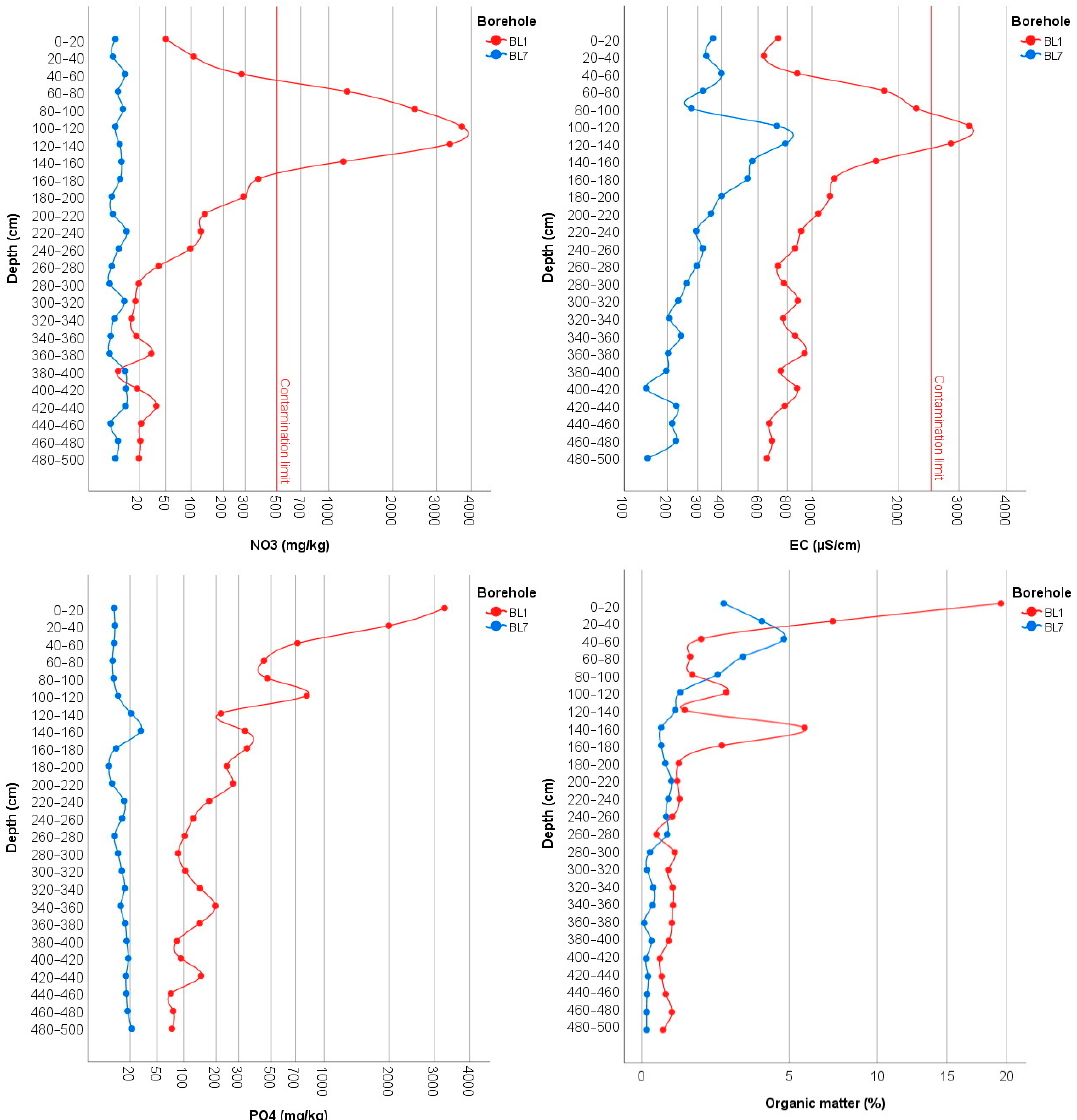
Figure 4. The vertical distribution of NO 3 − , EC, PO 43 − , and organic matter in the monitoring wells BL1 and BL7.